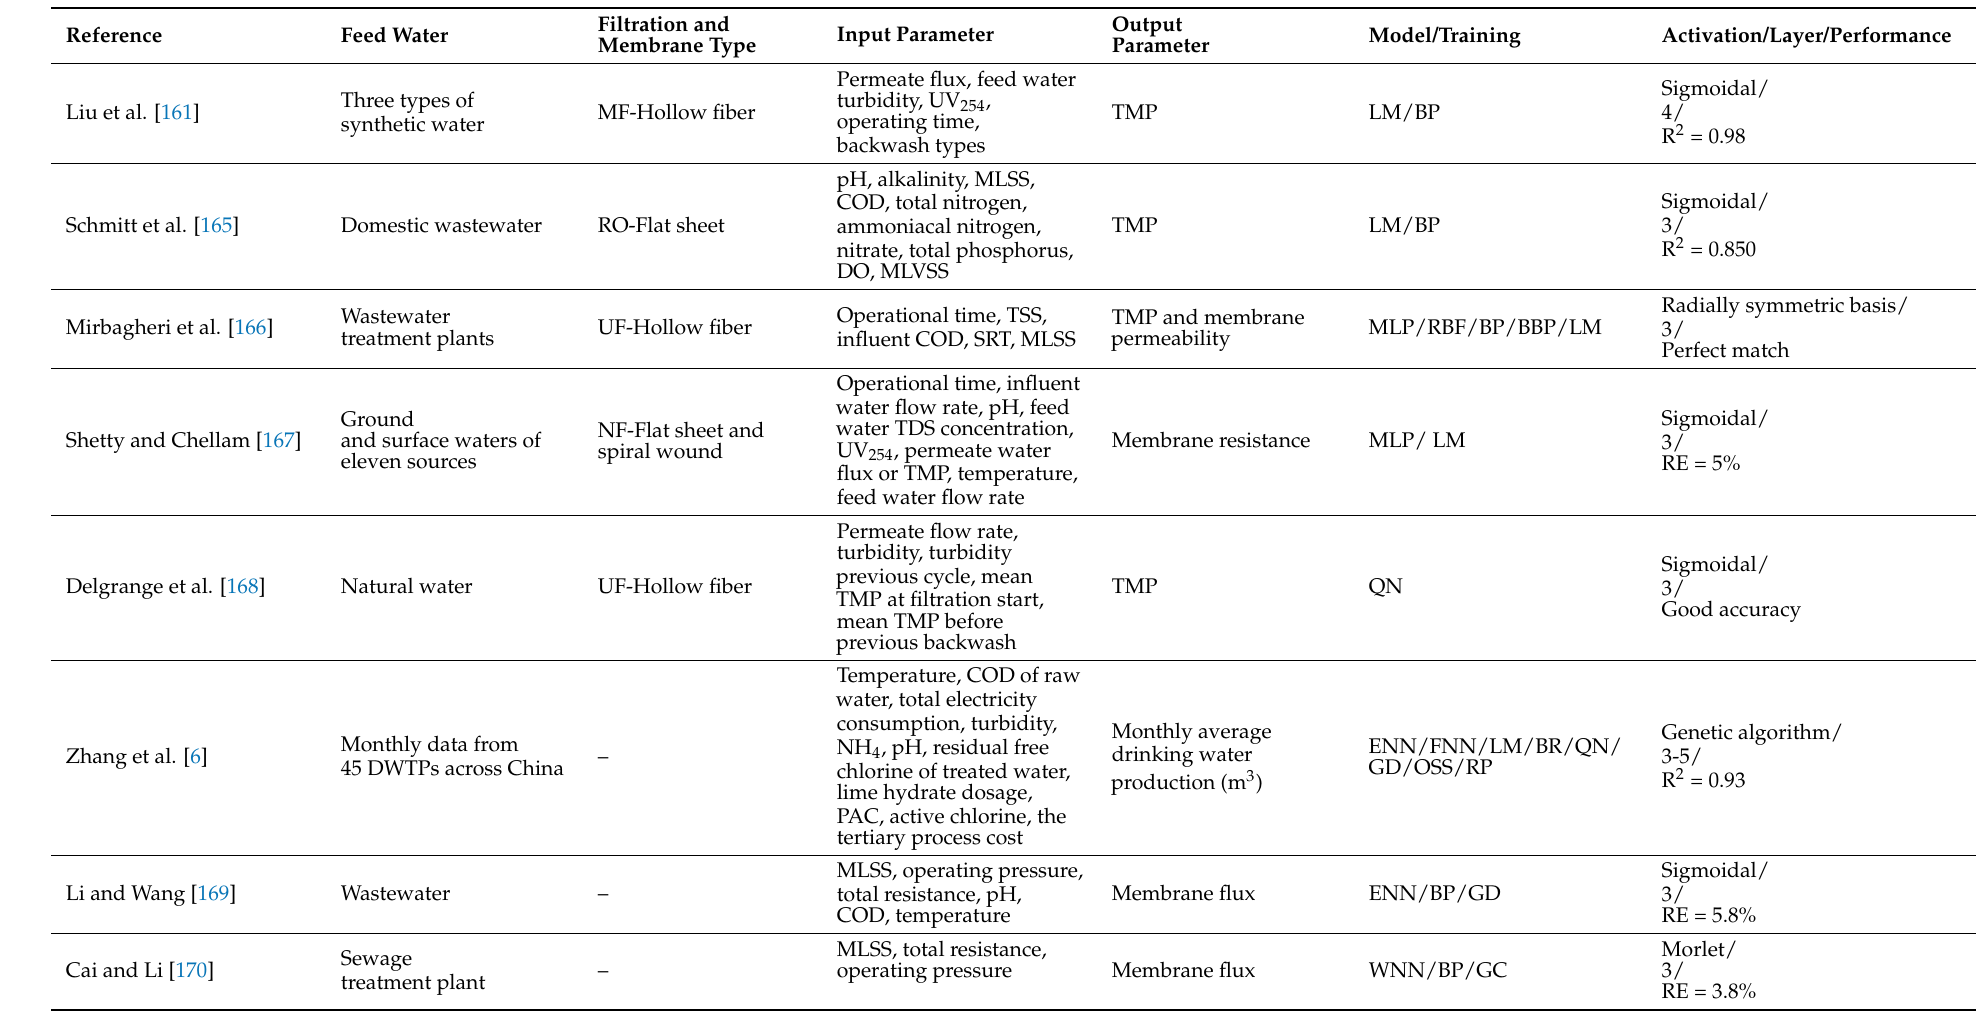
Table 6. ANN setting for the prediction of membrane fouling in drinking water